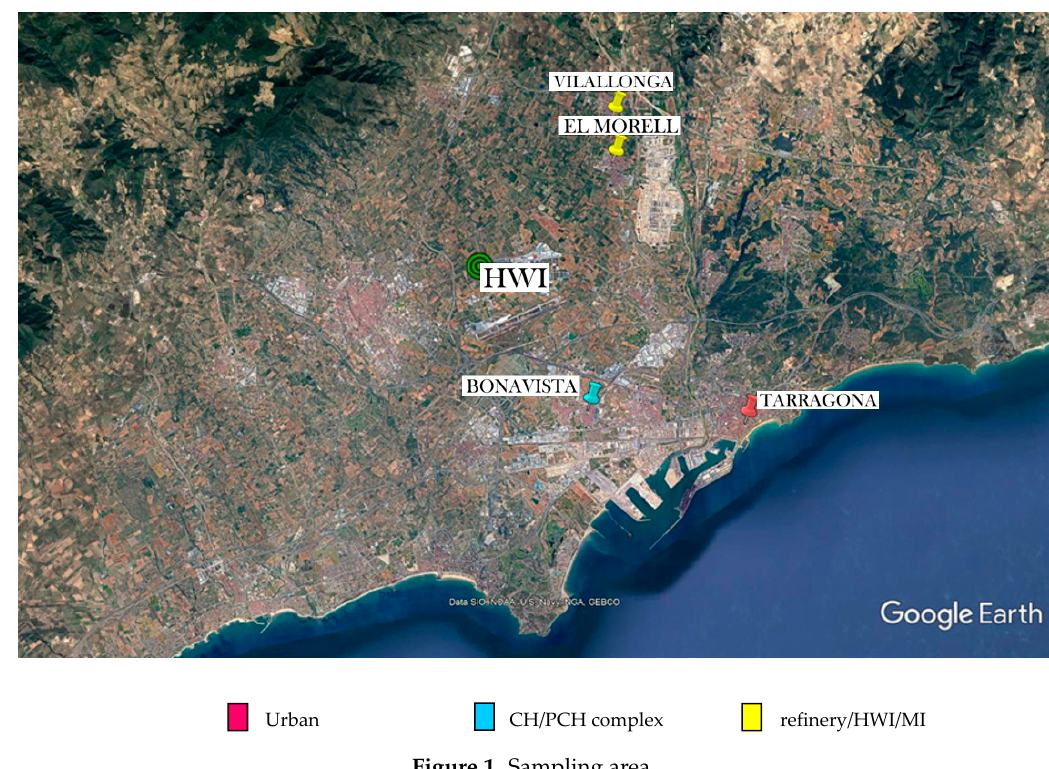
Figure 1. Sampling area.